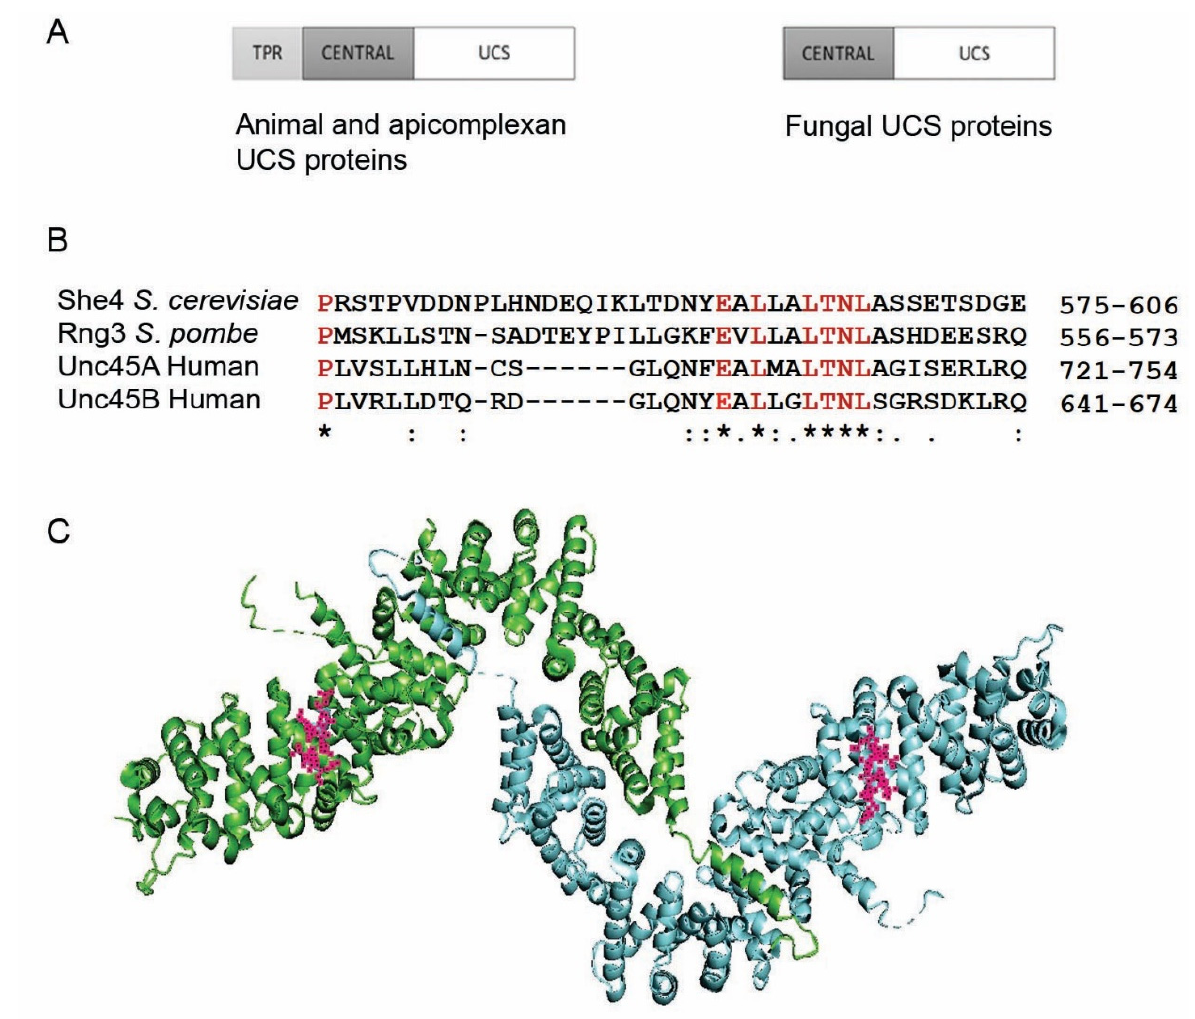
Figure 1. ( A ) Schematic diagram showing the domain structure of UCS proteins in animals and apicomplexan parasites ( left ) and fungi ( right ). ( B ) A small UCS sequence conserved from yeast to man. ( C ) The location (in red) of this E A L LA LTNL sequence in the two molecules within the unit cell of the X-ray crystal structure of She4, the UCS protein of the yeast Saccharomyces cerevisiae [17]. The UCS domain consists of repeats of an armadillo/beta-catenin-like motif, an ap- proximately 40 amino acid-long sequence that was first identified in the Drosophila segment polarity gene armadillo and the mammalian armadillo homolog beta-catenin. The X-ray crystal structure of the Drosophila UNC45 reveals an L-shaped monomer in which a con- tiguous series of these armadillo repeats are stacked one upon another [7]. Self-association of these stacks causes UNC45 to exist as oligomers in vitro and in vivo [6,11], linear chains of UNC45 units that effectively form an assembly line for the licensing of the folding of myosin heads with a defined periodicity on myofilaments. How the conserved sequences of the flexible UCS interact with myosin is discussed in detail elsewhere